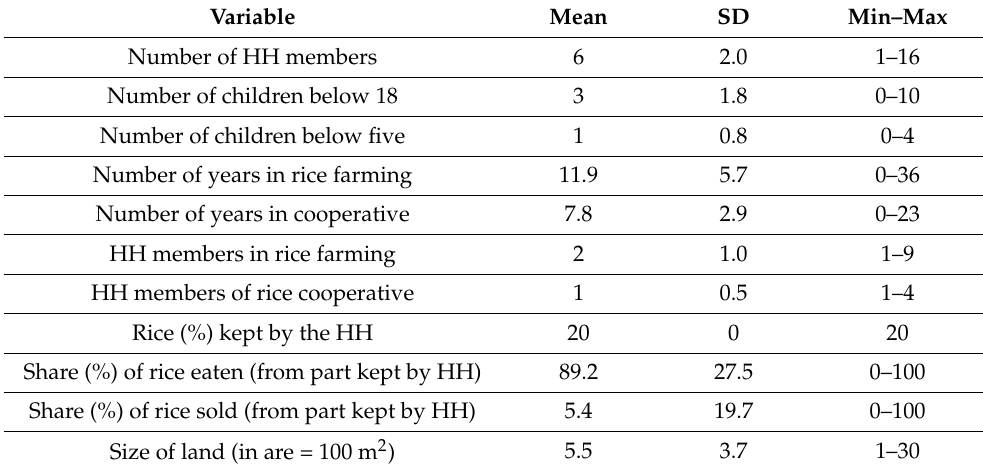
Table 2. Household profile of rice farmer respondents ( n = 320), Ruhuha,